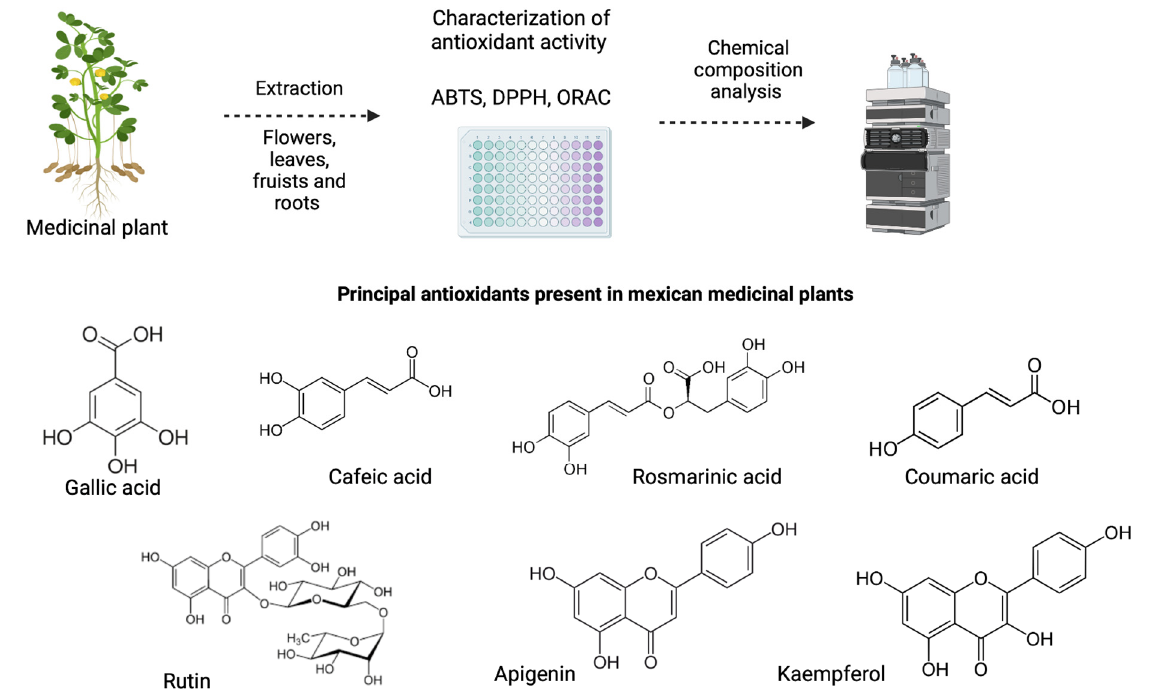
Figure 1. Process of antioxidant extraction and characterization and principal phenolic compound present in Mexican medicinal plants. Table 1. Antioxidant activity of di ff erent Mexican plants used in traditional medicine.